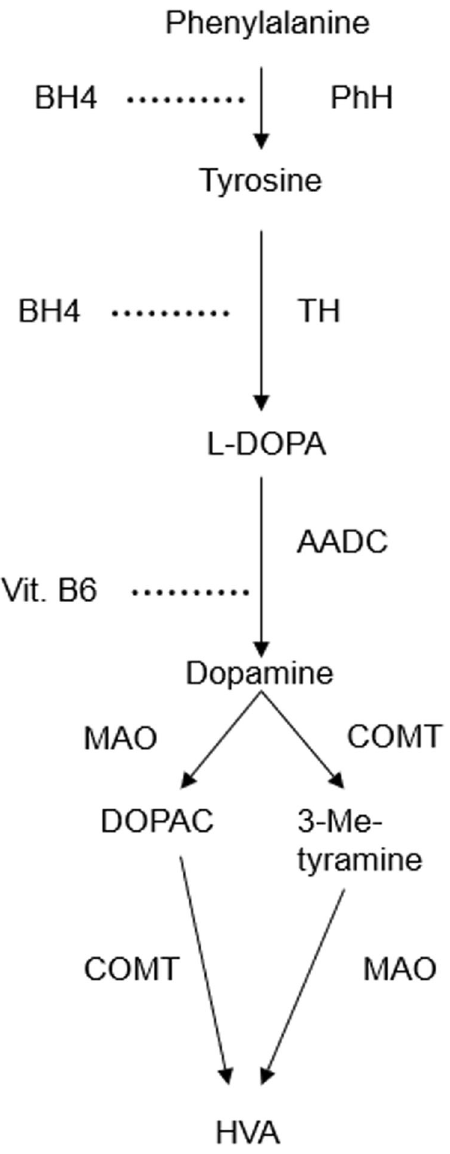
Fig. 1 Production and metabolism of dopamine. Levodopa is produced in a two-step enzymatic reaction by conversion of the amino acid phenylalanine into L -tyrosine by the enzyme phenyla- lanine hydroxylase (PhH), and further into L-tyrosine by the enzyme tyrosine hydroxylase (TH). It is a direct precursor to the neuro- transmitter dopamine (3,4-dihydroxyphenethylamine) by the action of the enzyme aromatic L -amino acid decarboxylase (AADC). Further breakdown of dopamine into 3-methoxy-tyramine, 3,4-dihydroxy- phenylacetic acid (DOPAC) and homovanillic acid (HVA) is mediated by the enzymes catechol-O-methyltransferase (COMT) and mono- amine oxidase (MAO) 5 . Vitamin B6 (vit. B6) is a co-factor for AADC; tetrahydrobiopterin (BH4) is a co-factor for both PhH and